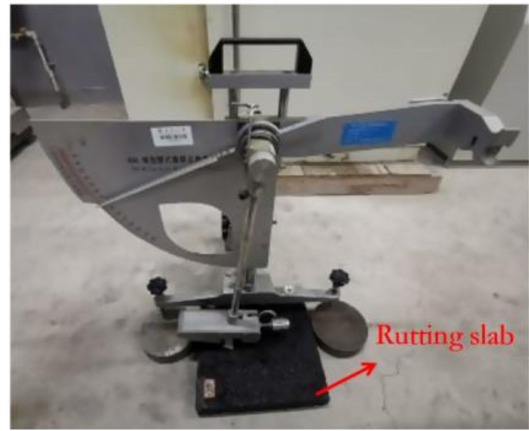
Figure 6. British pendulum